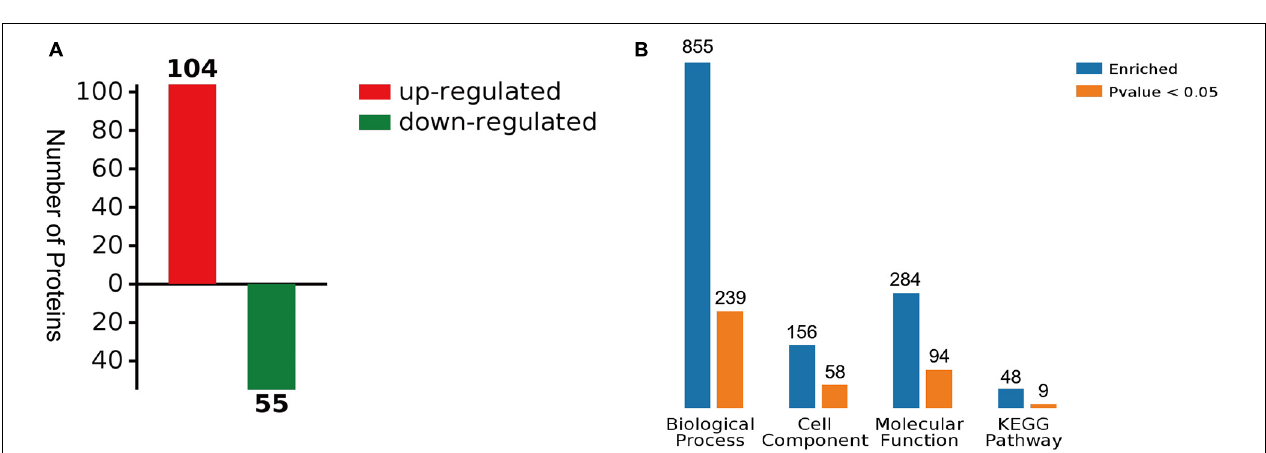
FIGURE 2 | Relative expression levels of HSP70 (A) , HSP90 (B) , and CYP450 (C) transcripts in the C. farreri after 24 h, 48 h, and 96 h exposure to OA ( n = 3). Asterisks indicate significant differences between the control and OA-exposed group within each fixed sampling period, and different letters indicate significant differences among different sampling periods within each treatment ( p < 0.05).